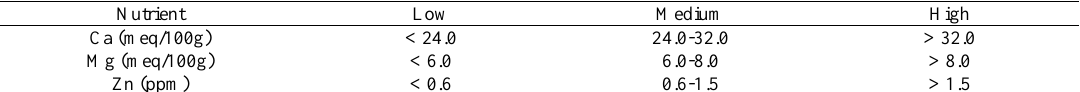
Table 1. The permissible limits of pH, Ca, Mg, and